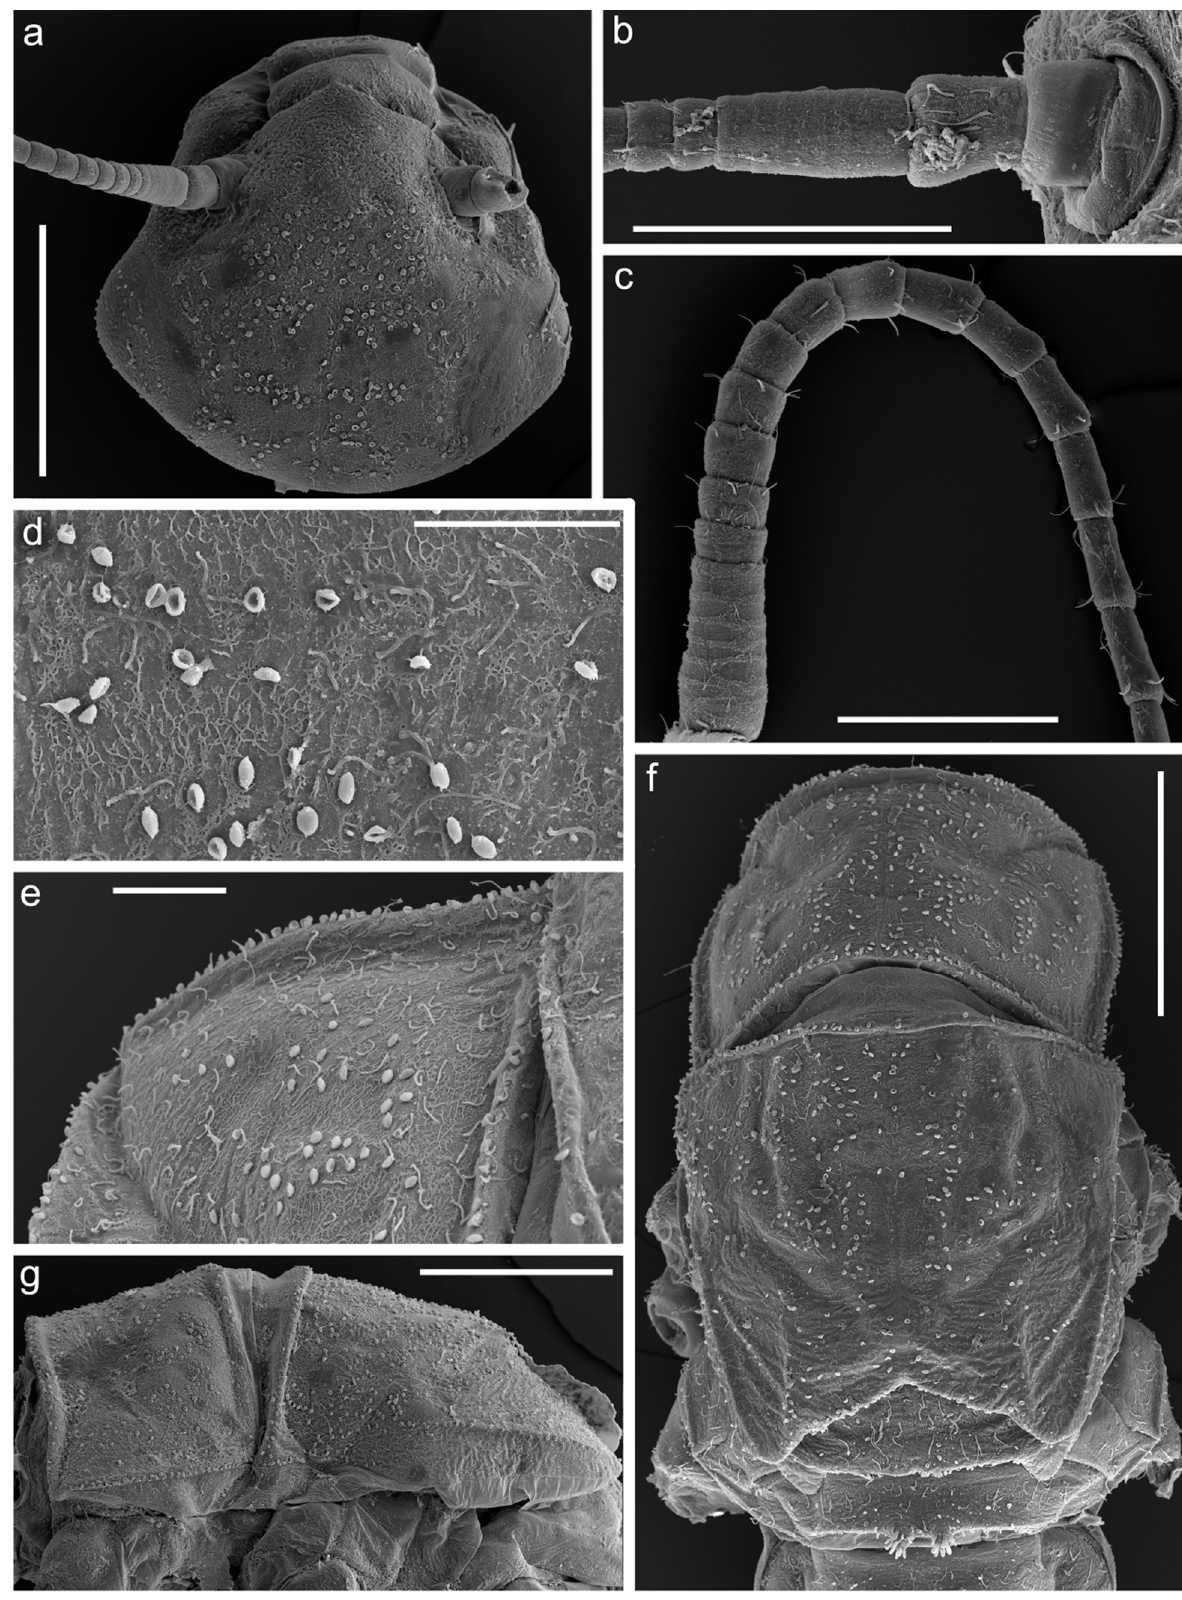
Figure 3. Larva of Serratella leonidi Martynov & Palatov, sp. nov. , paratypes. ( a ) Head, ( b ) antenna (scapus, pedicelus and part of flagellum), ( c ) flagellum, ( d , e ) dorsal surface of pronotum with bubble-like setae, ( f ) thorax, dorsal view, ( g ) thorax, lateral view. Scale bars: ( a , g , f )—0.5 mm, ( b )—0.25 mm, ( c )—0.2 mm, ( d , e )—0.1 mm.